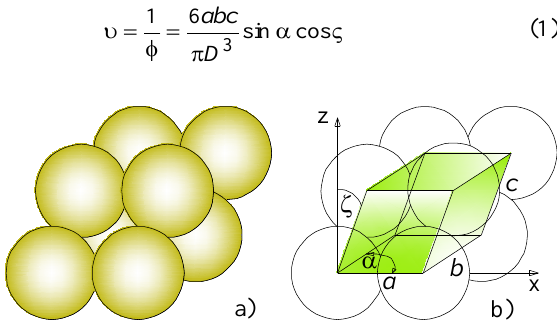
Fig. 1 . Geometry of the ordered packing of spheres: a) volumetric view, b) parameters of the basic